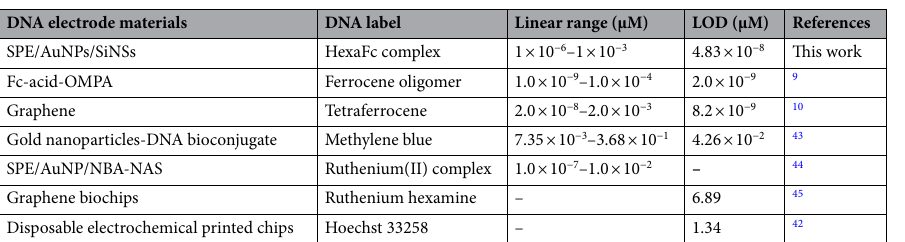
Table 3. Comparison of performance between the DNA biosensor reported here with other biosensors using different ferrocene and non-ferrocene based compounds as an indication of hybridisation.